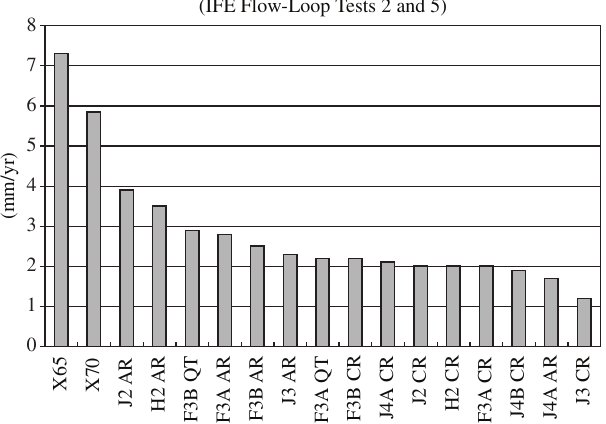
Figure 5. Flow-loop corrosion tests showing corrosion rate for a range of steels from the 60 kg melts.